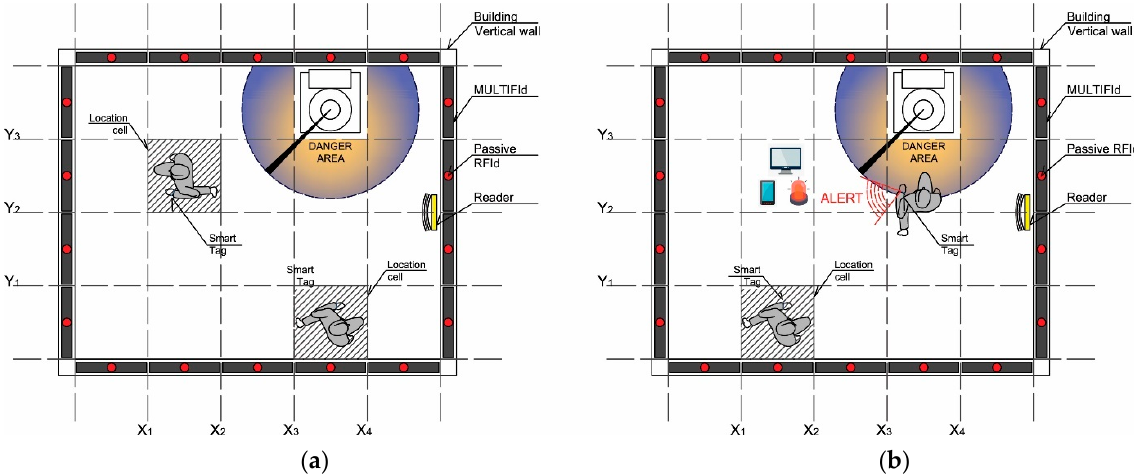
Figure 7. Horizontal section of an example scenario: ( a ) two operators are far from the danger area and their position is monitored; ( b ) one of the two operators moves close to a danger tool.